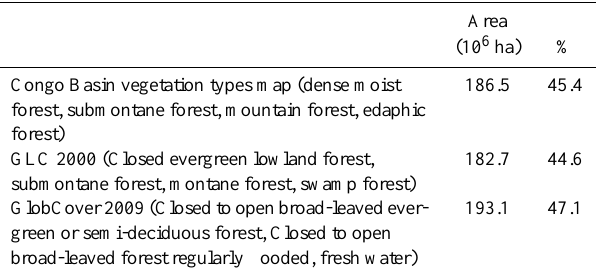
Table 10. Dense tropical forest areas from the vegetation types map, GLC 2000 and GlobCover 2009.